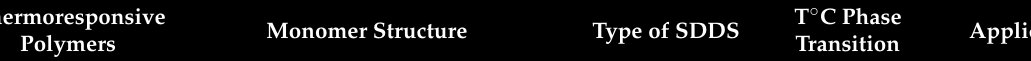
Treatment of cutaneous